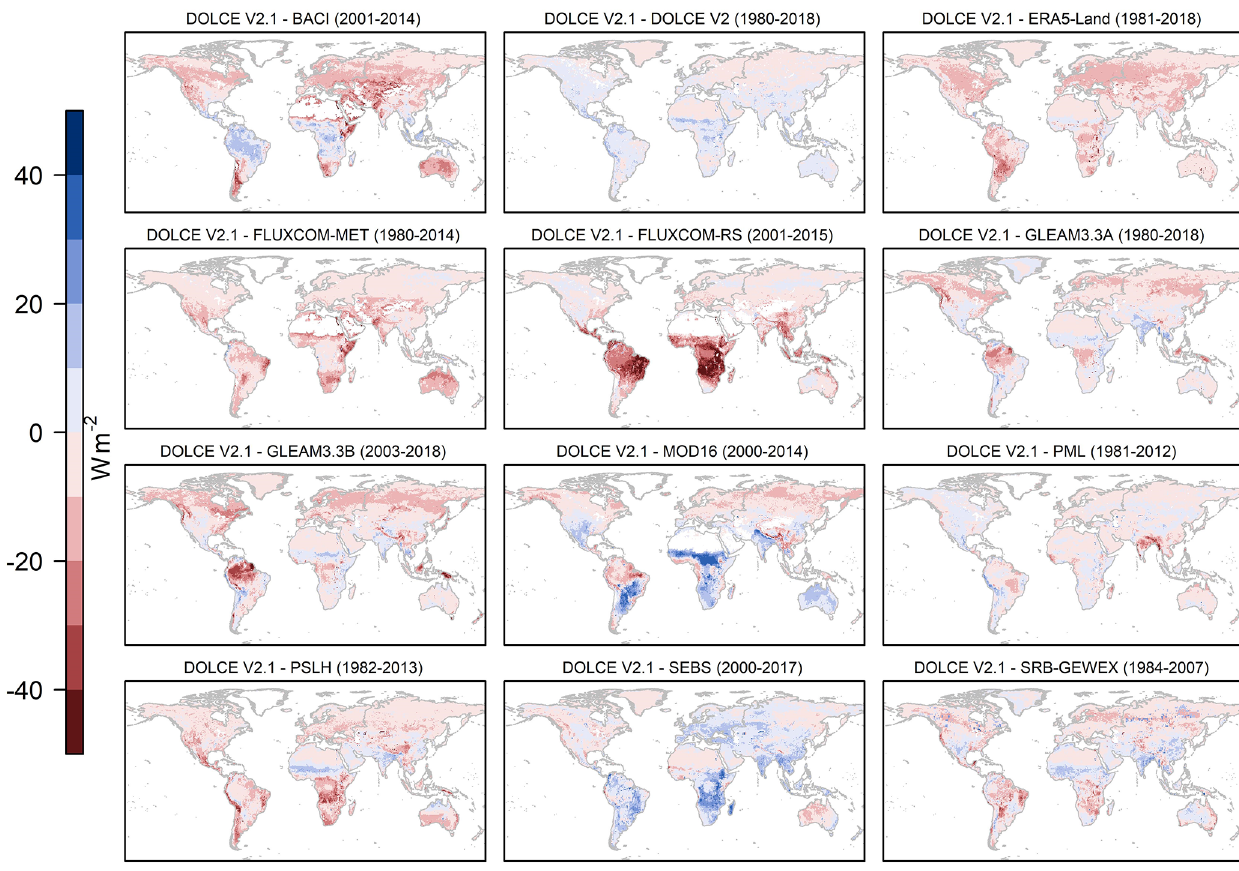
Figure 2. Spatial distribution of differences in ET climatology between DOLCE V2 and each of its parent datasets and DOLCE V1. Different spatio-temporal masks are applied for each comparison based on the spatio-temporal coverage of DOLCE V2 and the other